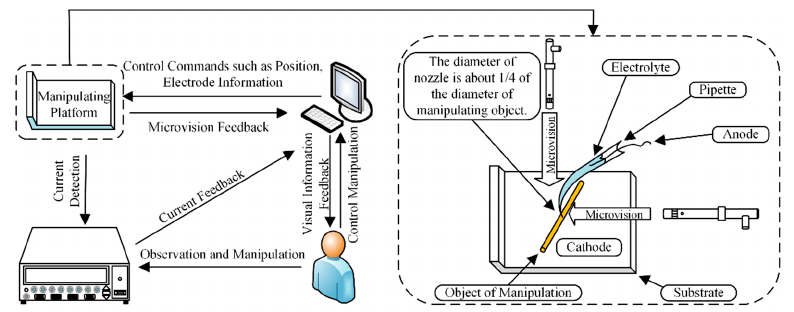
Figure 2. Experimental device and process of